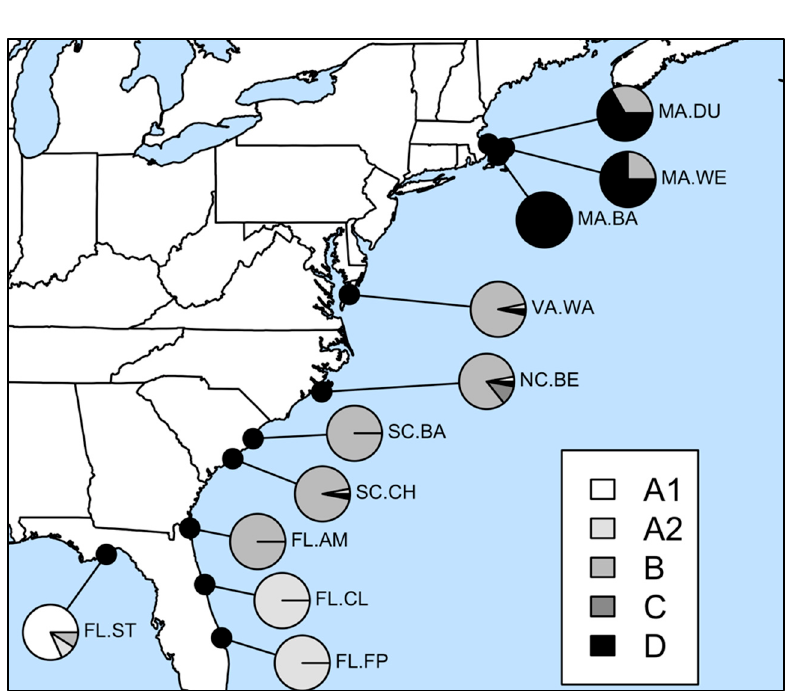
Figure 2. Geographic distribution of COI clades (labeled A1-D; see Figure 1) of Diopatra cuprea . The overall F ST across all populations was 0.728 ( p < 0.001) and the overall F ST across the four regions (FL-Gulf; FL-Atlantic; mid-Atlantic; MA) was 0.826 ( p < 0.001). Tables 4 and 5 indicate the pairwise F ST among the populations and regions, respectively. Table 4. Pairwise PhiST (below diagonal) and p -values (above diagonal) among populations.